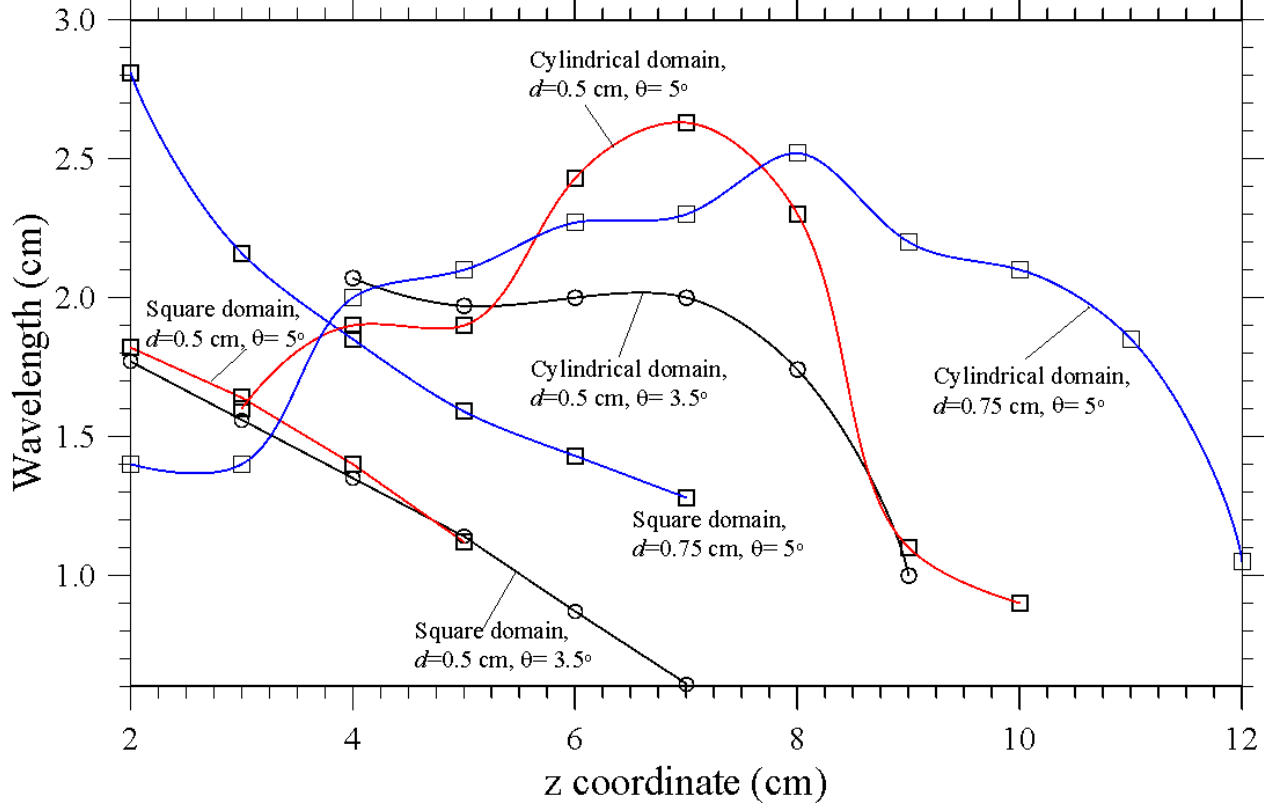
Figure 19. Transverse roll extension as a function of the longitudinal direction z for all the cases considered in the present work ( ∆ T = 27 °C).